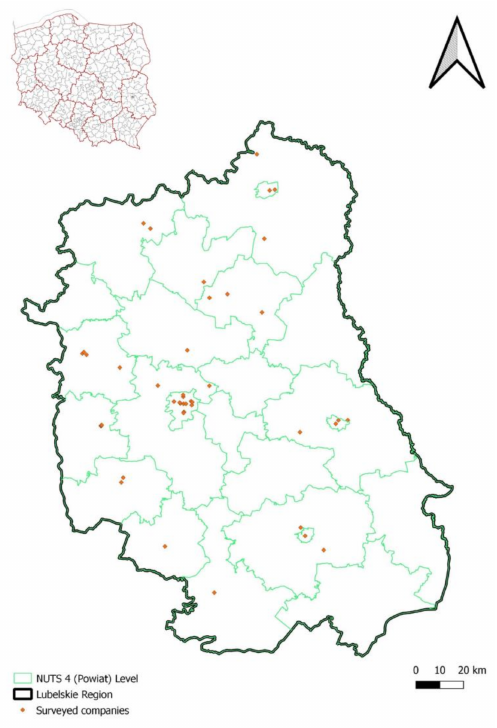
Figure 1. Map of the Lubelskie Region with the location of surveyed companies. In addition, surveys were carried out in the bio-refineries in the Lubelskie Region producing bioethanol and biodiesel, and in biogas plants located in the region. Based on the surveyed data, expert opinions, and data from financial reports, nine new bioeconomy sectors were created, separate from mixed sectors. The share for sectors such as bioethanol, biodiesel, biogas, or electricity production (biomass) could not be compared with each other (European Union versus Poland or the Lubelskie Region) due to different calculation methods used. As can be seen in Table 2, the bio-based share is lower in the Lubelskie Region in comparison with Poland or the European Union. Lower shares of mixed bio- based sectors may result from the fact that the Lubelskie Region is one of the poorest regions in Europe. Research and development is related to the companies’